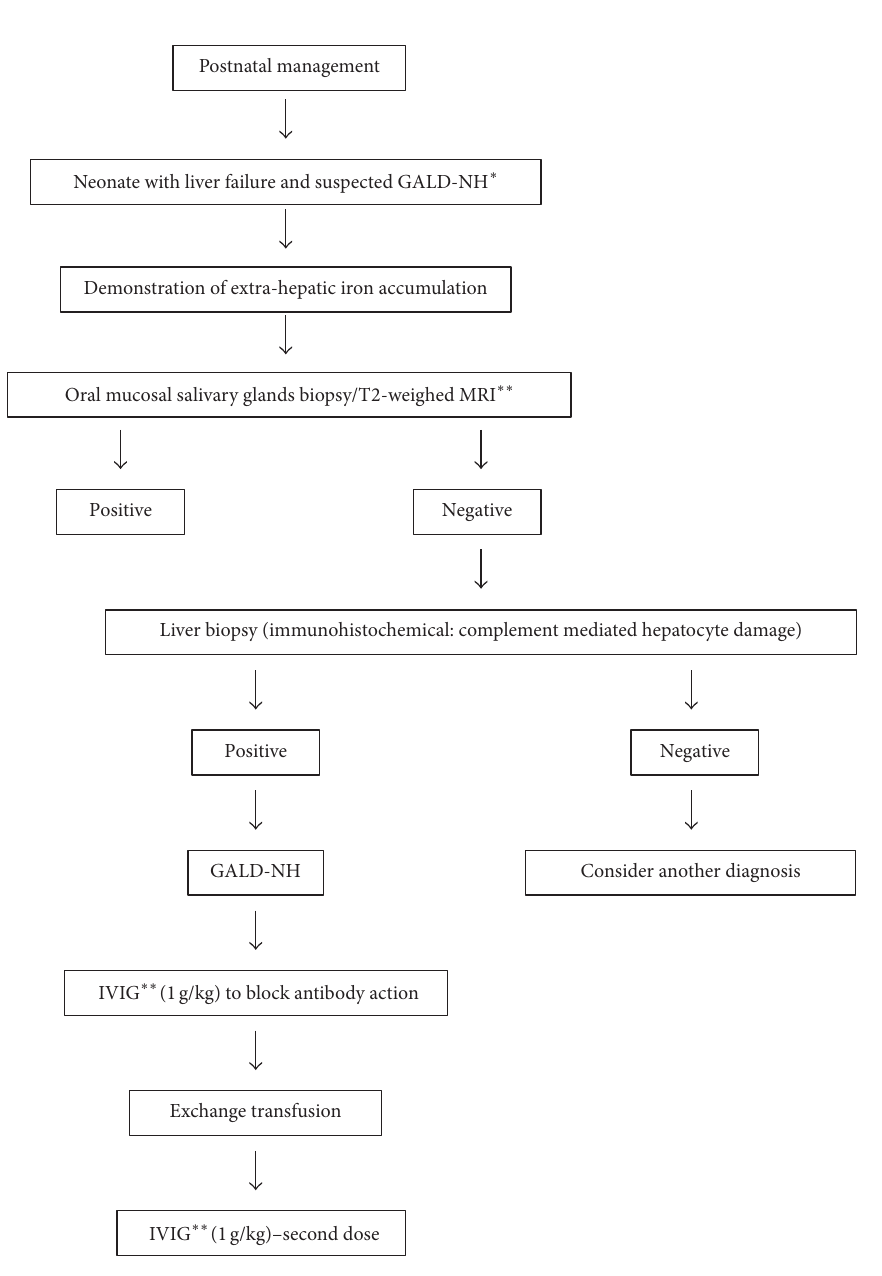
Figure 2: Diagnostic and management algorithm for gestational alloimmune liver disease-neonatal hemochromatosis. ∗ GALD-NH is gestational alloimmune liver disease-neonatal hemochromatosis; ∗∗ IVIG is intravenous immunoglobulin (modified from Lopriore et al.,